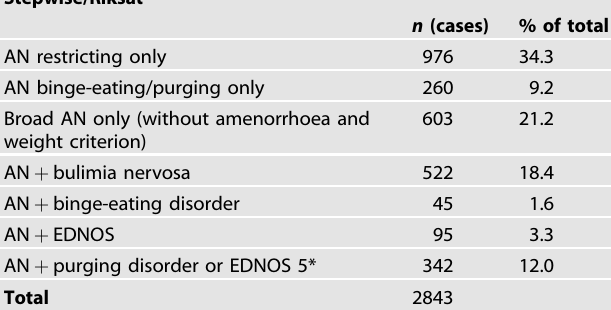
Table 1. Lifetime eating disorder diagnoses registered in Swedish quality registers Riksät/Stepwise among individuals with a lifetime diagnosis of anorexia nervosa (AN) included in our target sample ( n =